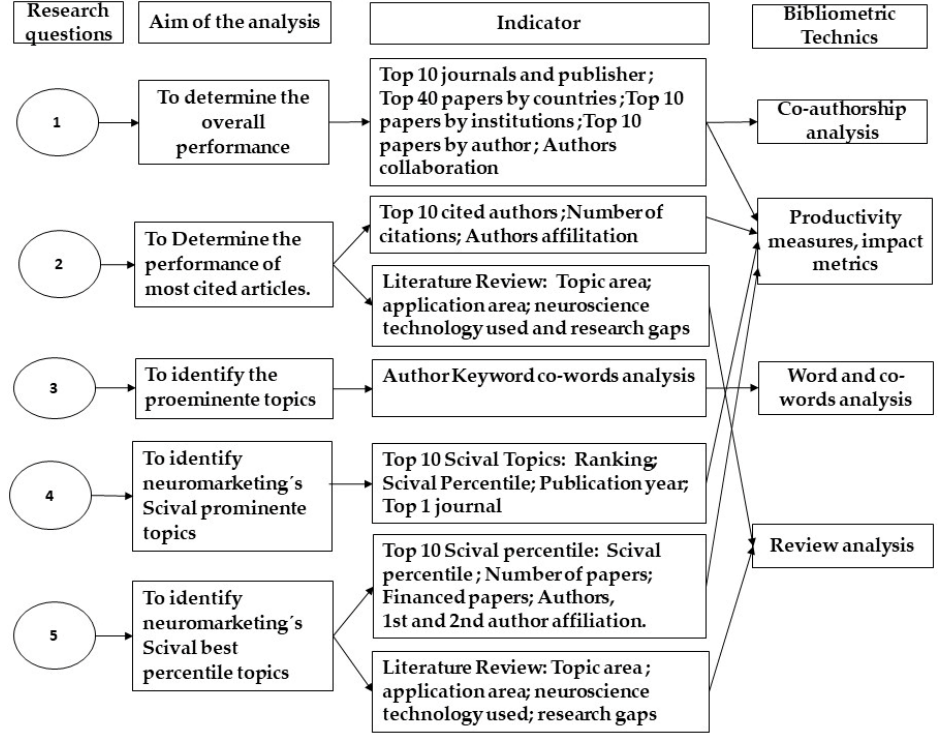
Figure 1. Summary of research questions, indicators, and technics used.